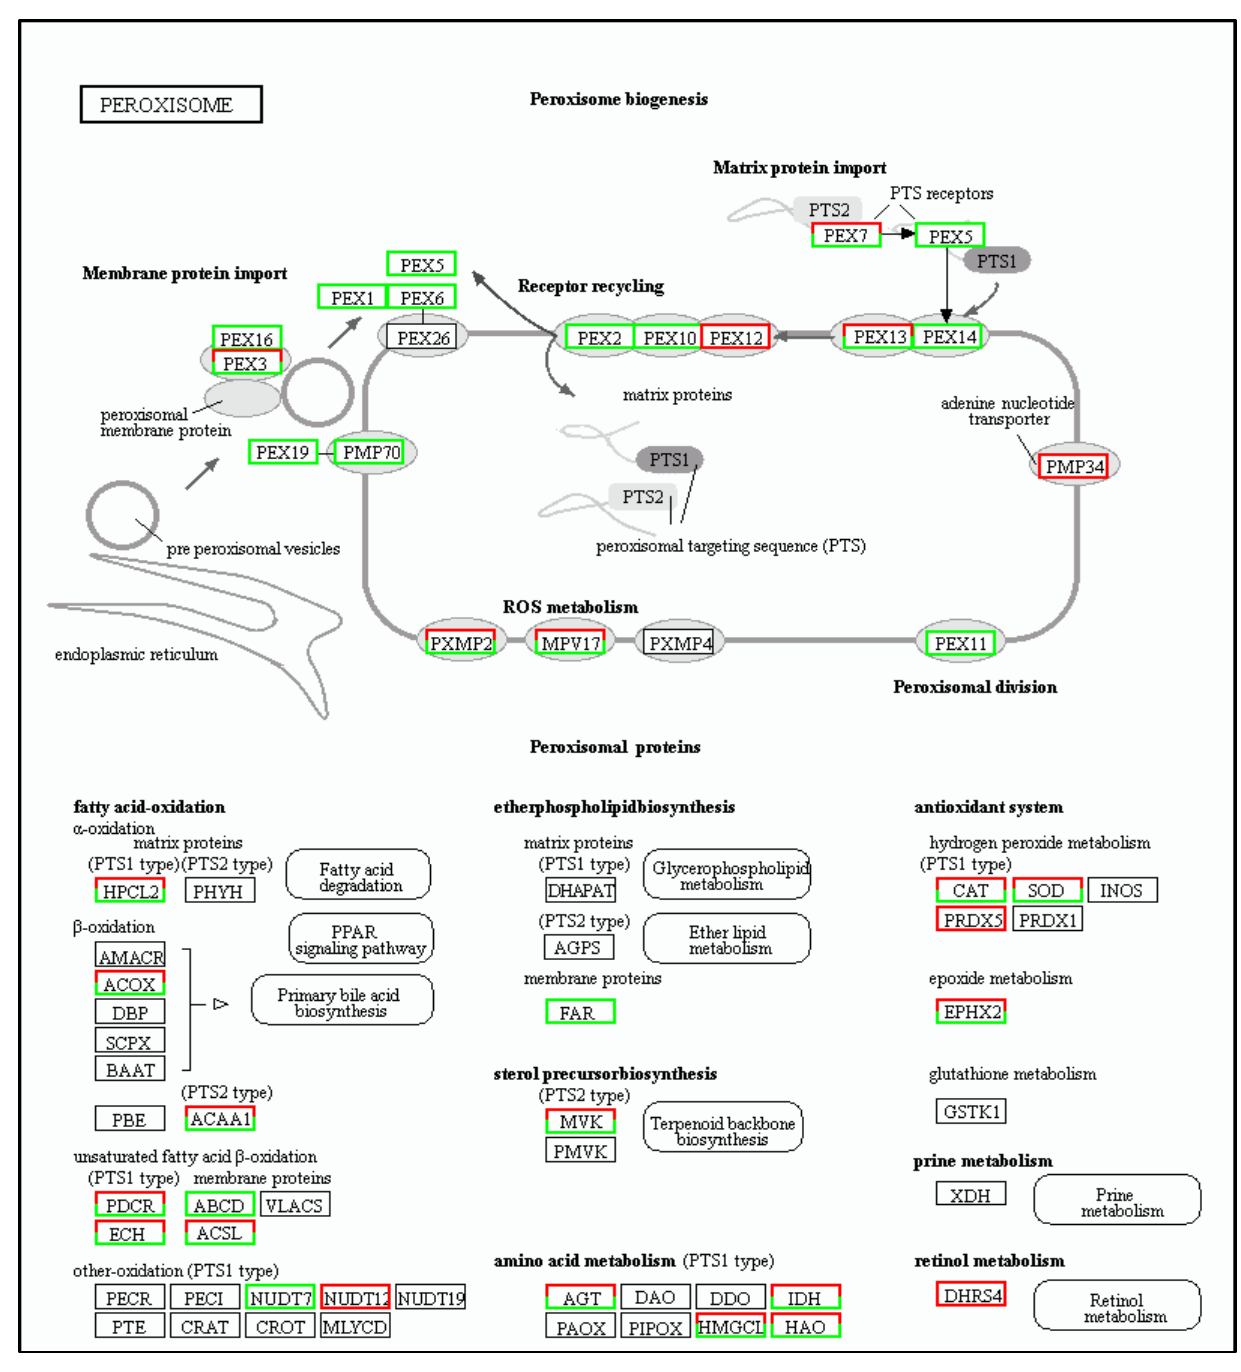
Figure 8. The cold tolerance genes of tea plants involved in peroxisome pathways. Red boxes representing the upregulation of genes and green ones representing their downregulation.